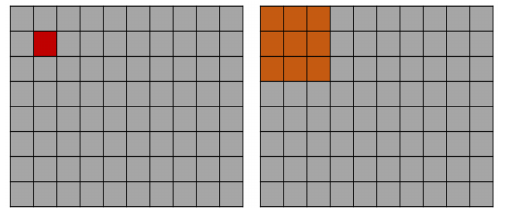
Figure 5. Line position encoding for fast matching. Left : position grid of the mapped lines of the IR image in the VS image; Right : position grid of the lines in the VS image. Mapped line segments with the middle points located in the red bin will only be paired with the VS line segments with the middle points located in the neighbouring nine orange bins for further